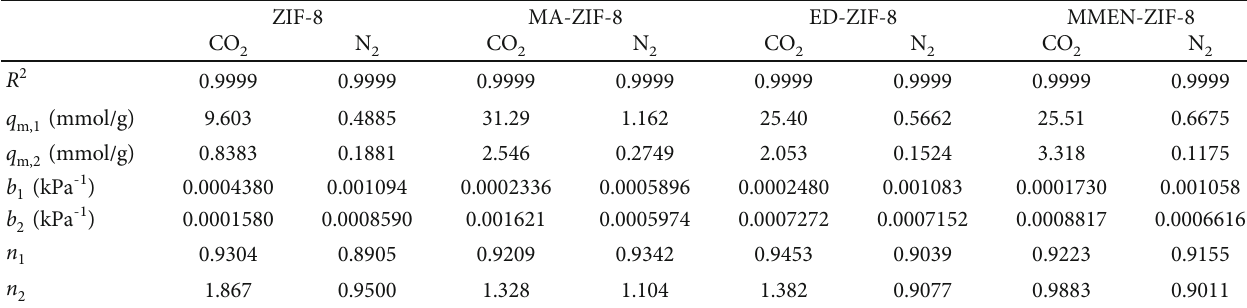
Figure 7: DSLF fi tting of the CO Table 2: The fi tting parameters of the DLSF model for the pure component isotherms of CO